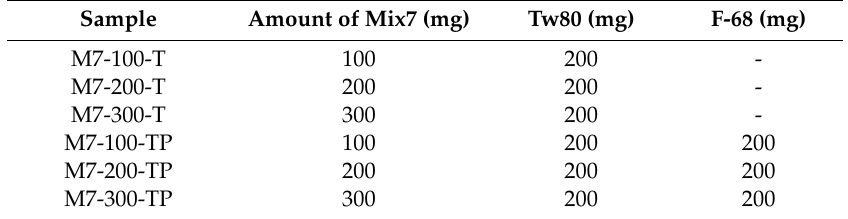
Table 2. Composition of prepared nanostructured lipid carriers (NLCs) using 20 mL of aqueous